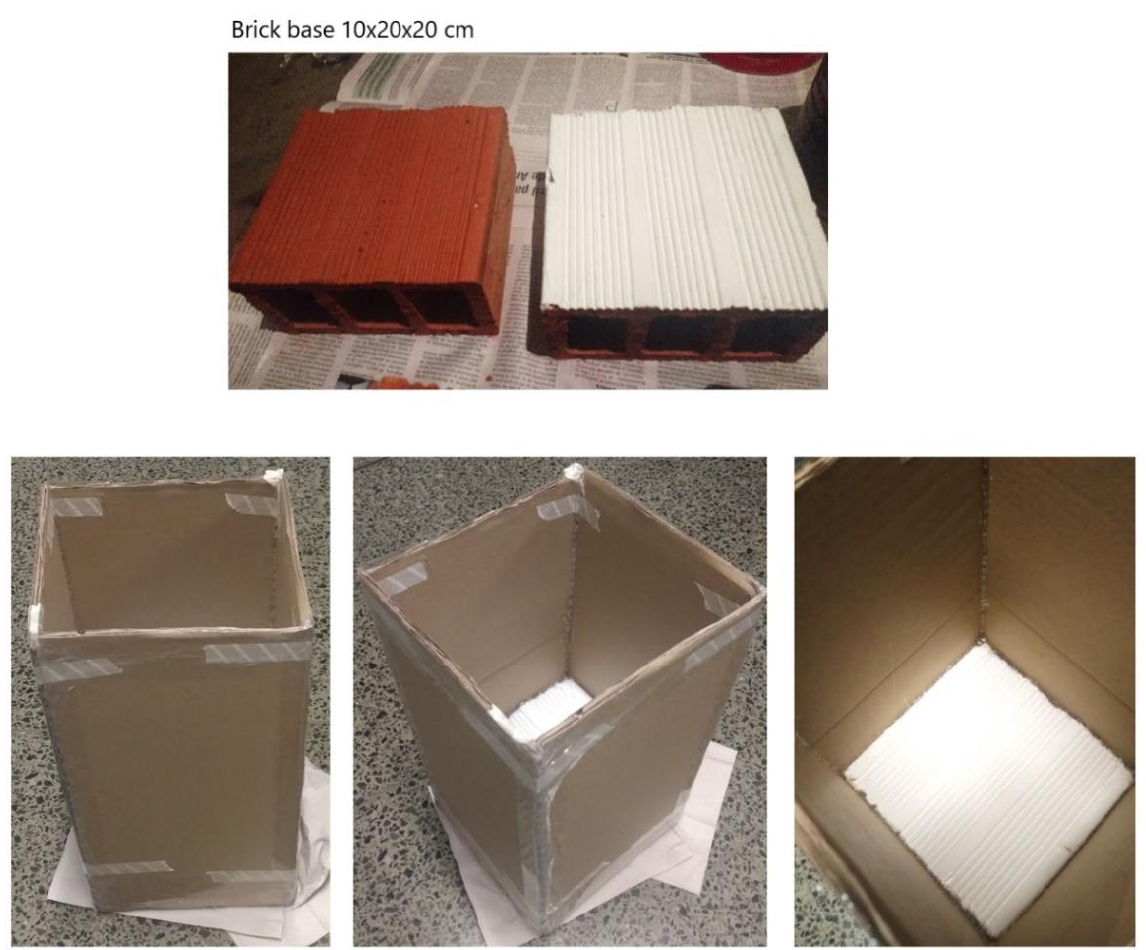
Figure 2. Bioassay prototype chambers for triatomine exposure to micro-encapsulated insecticidal paint. Triatomines were exposed for 1 h inside the chambers for follow-up at 24 – 48 h post exposure.